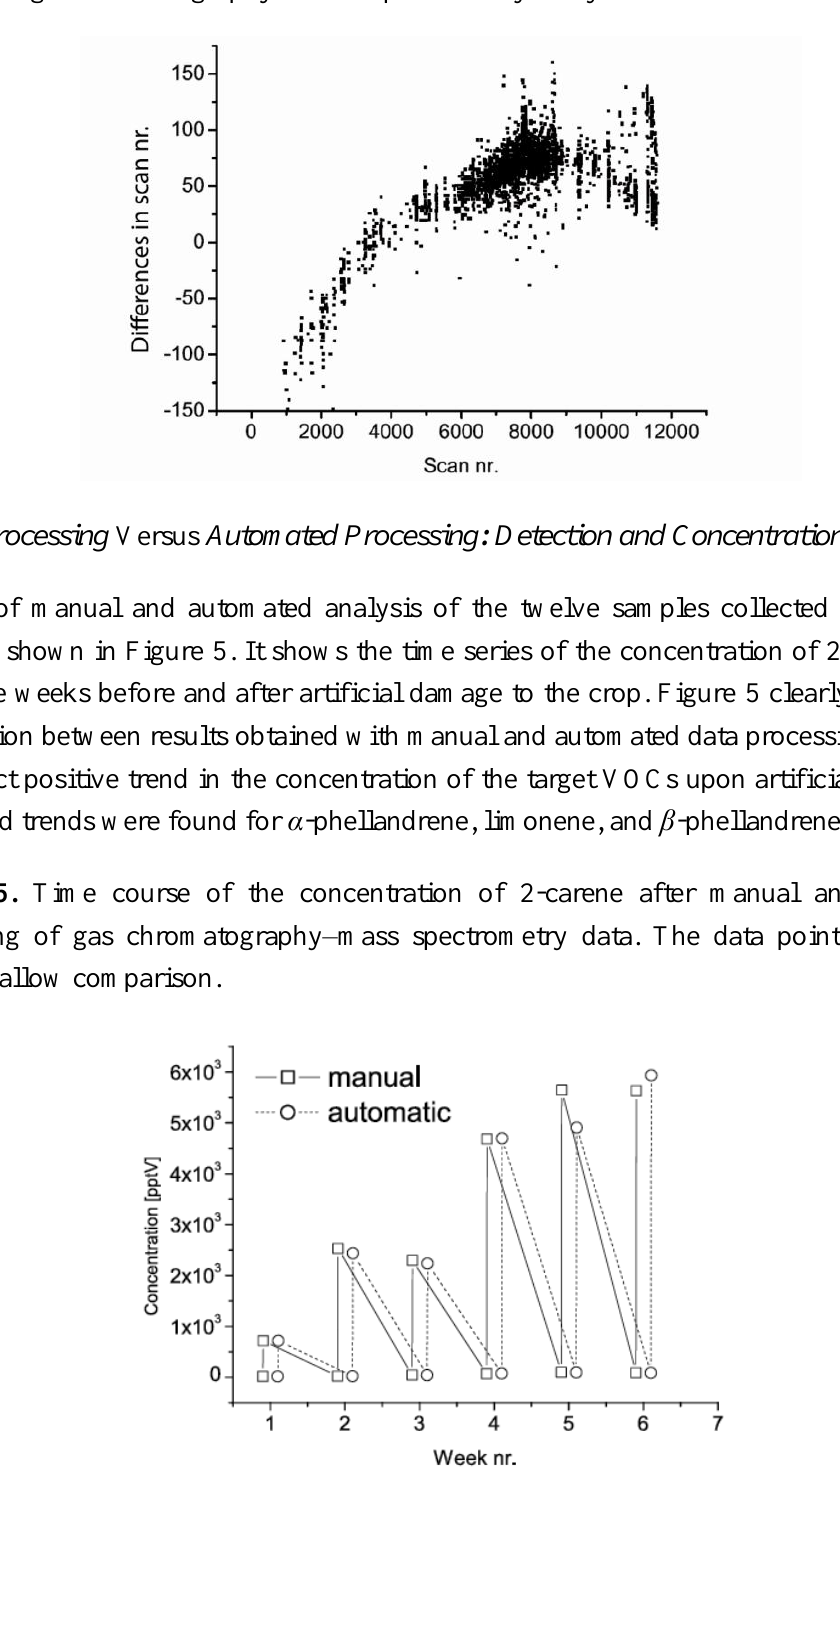
Figure 4. Differences in scan numbers for signals representing volatile organic compounds detected in gas chromatography—mass spectrometry analysis.